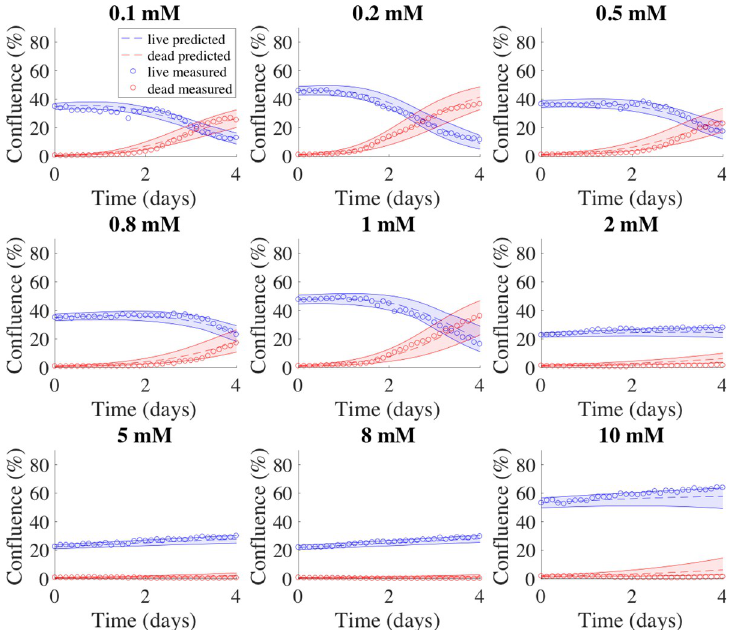
Fig 4. Model predictions for BT-474 cells. Example model predictions from one validation set of BT-474 cells are shown in dashed lines. In each panel, data measured from experiments are shown in circles, while the 95% confidence intervals for the predicted tumor cell growth and dead cell accumulation numbers are shown with shaded regions between the solid curves; with blue indicating live cells, and red indicating dead cells. The initial glucose level is shown above each plot. For this validation set, the model prediction accuracy was 72.2 ± 8.6% and 49.3 ± 10.0% for live and dead cells,